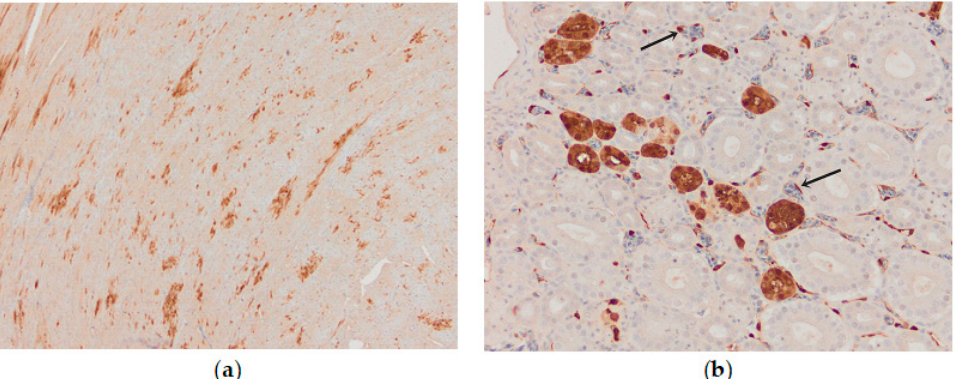
Figure 10. Immunohistochemical distribution of influenza viral nucleoprotein antigen in the tissues of chickens infected with H5N8 HPAI. ( a ) Heart, AIV nucleoprotein in the nucleus and cytoplasm of myocytes, bar × 100. ( b ) Kidney, AIV nucleoprotein in the tubular epithelial cells and vascular endothelial cells (arrow), bar × 400. Table 1. Histopathological changes and average distribution of viral antigen–positive cells in tis- sues sampled from domestic chickens naturally infected with the HPAI H5N8 virus.